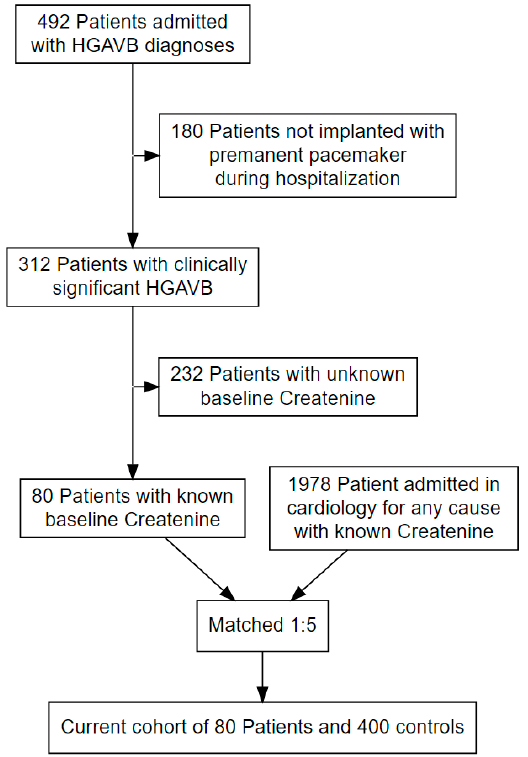
Figure 1. Flow chart describing inclusion of patients to the cohort. Other baseline characteristics and balance measures are summarized in Table 1. Pa- tients with HGAVB had a lower heart rate (66.0 ± 19.3 vs. 75.3 ± 20.6, p = 0.001) yet similar values of systolic and diastolic blood pressure measurements ( p > 0.718). Other clinical characteristics at hospital admission are detailed in Table 2. Table 1. Baseline characteristics of the entire cohort, high grade AV block (HGAVB) patients and controls.